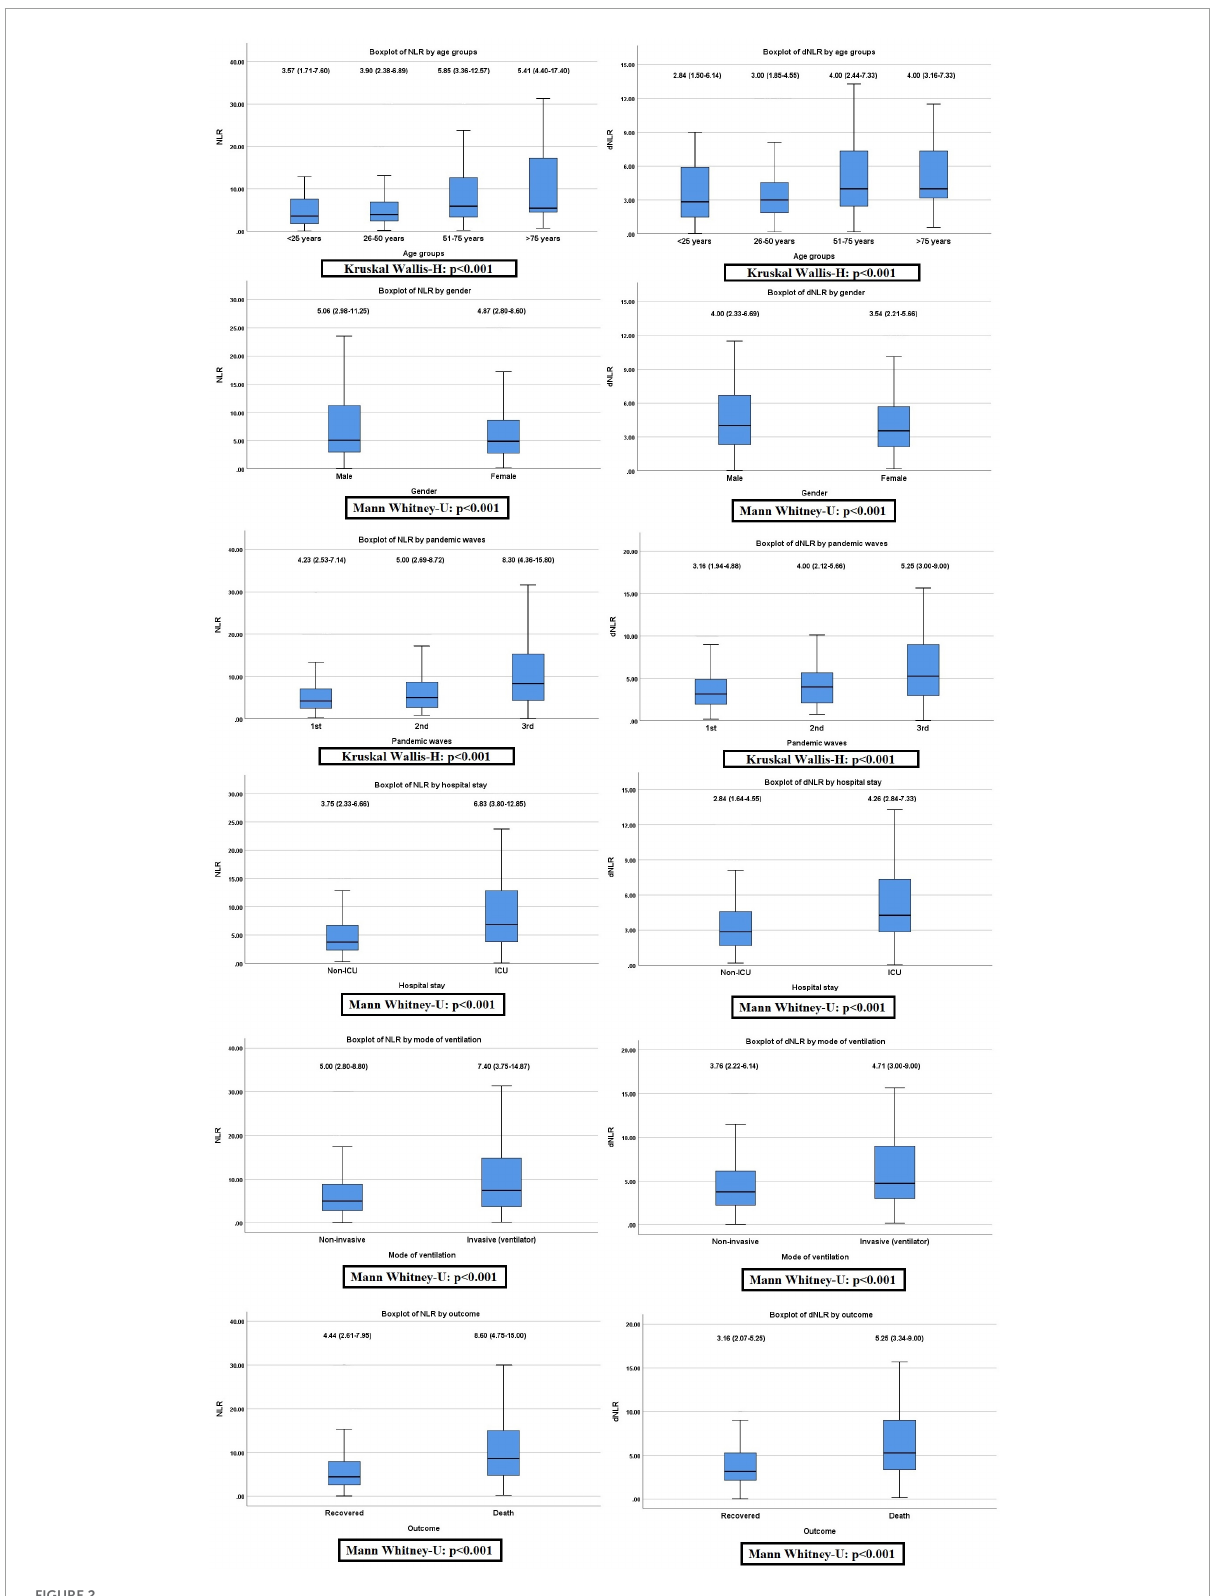
FIGURE2 Non-parametric distribution of neutrophil to lymphocyte ratio (NLR) and derived NLR (dNLR) among the study variables (Mann–Whitney U -test or Kruskal–Wallis H -test applied as indicated).